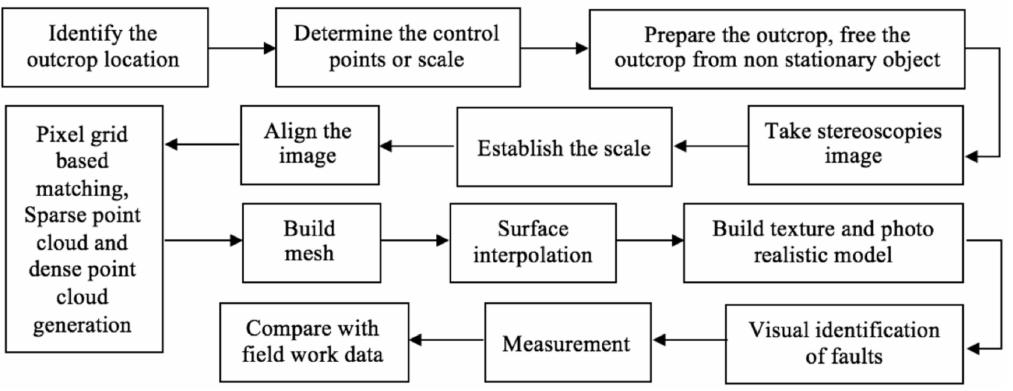
Figure 8. General framework of outcrop